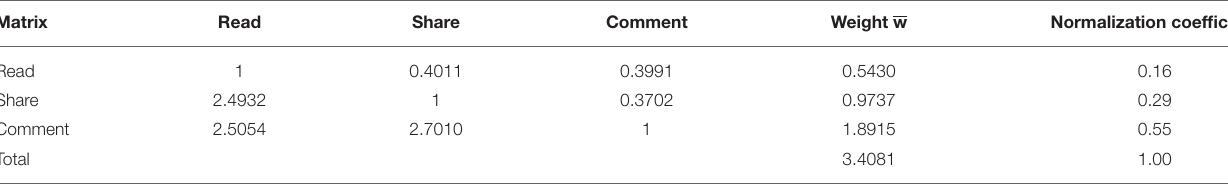
TABLE 2 | Judgement matrix and paired